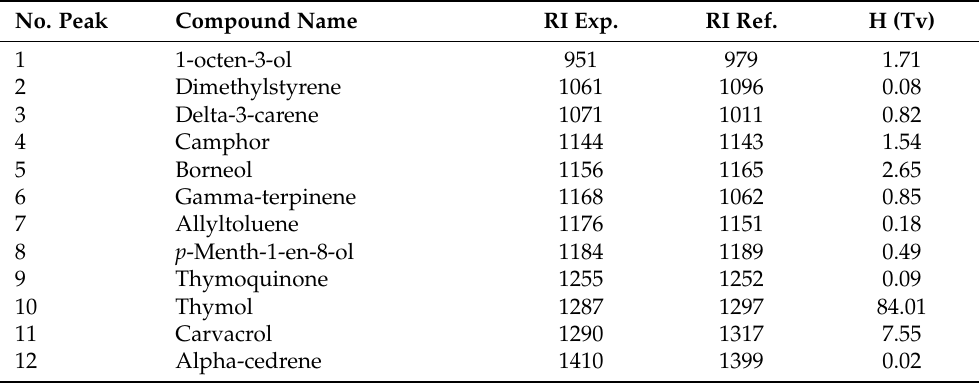
Table 2. Phytochemical composition (%) of hydrolate (H) of Thymus vulgaris (Tv) used in this study, via GC-MS. RI exp: retention index calculated with our experimental results; RI ref: retention index found in the literature for the same compound (source: Pherobase).